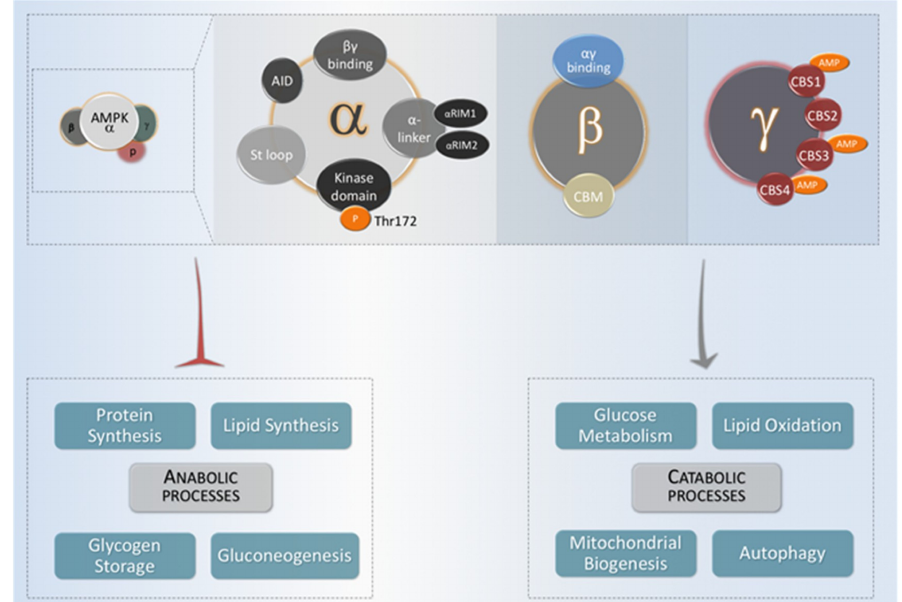
Figure 1. The domain structure of AMPK (adenosine monophosphate-activated protein kinase) heterotrimer. Functional AMPK complexes consist of one catalytic and two regulatory subunits. When activated, AMPK acts by decreasing energy-consuming anabolic processes (lipid synthesis, glycogen storage, gluconeogenesis, and protein synthesis) and increasing energy-providing catabolic processes that provide ATP (glucose metabolism, lipid oxidation, mitochondrial biogenesis and